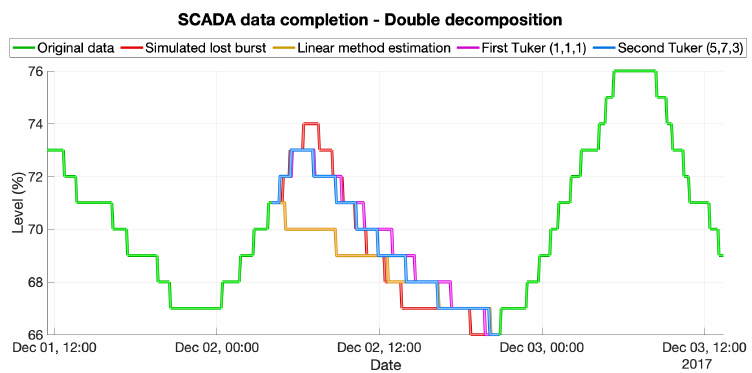
Figure 12. Example of the reconstruction methodology with double decomposition. The green line shows the original data and the red line the burst of lost samples. The orange line is the linear estimation with the ramp method . The purple line is the result of the first tensorization procedure with Tucker using G 4 × 6 × 1 . The blue line shows the result of the second tensorization procedure with G 4 × 7 × 7